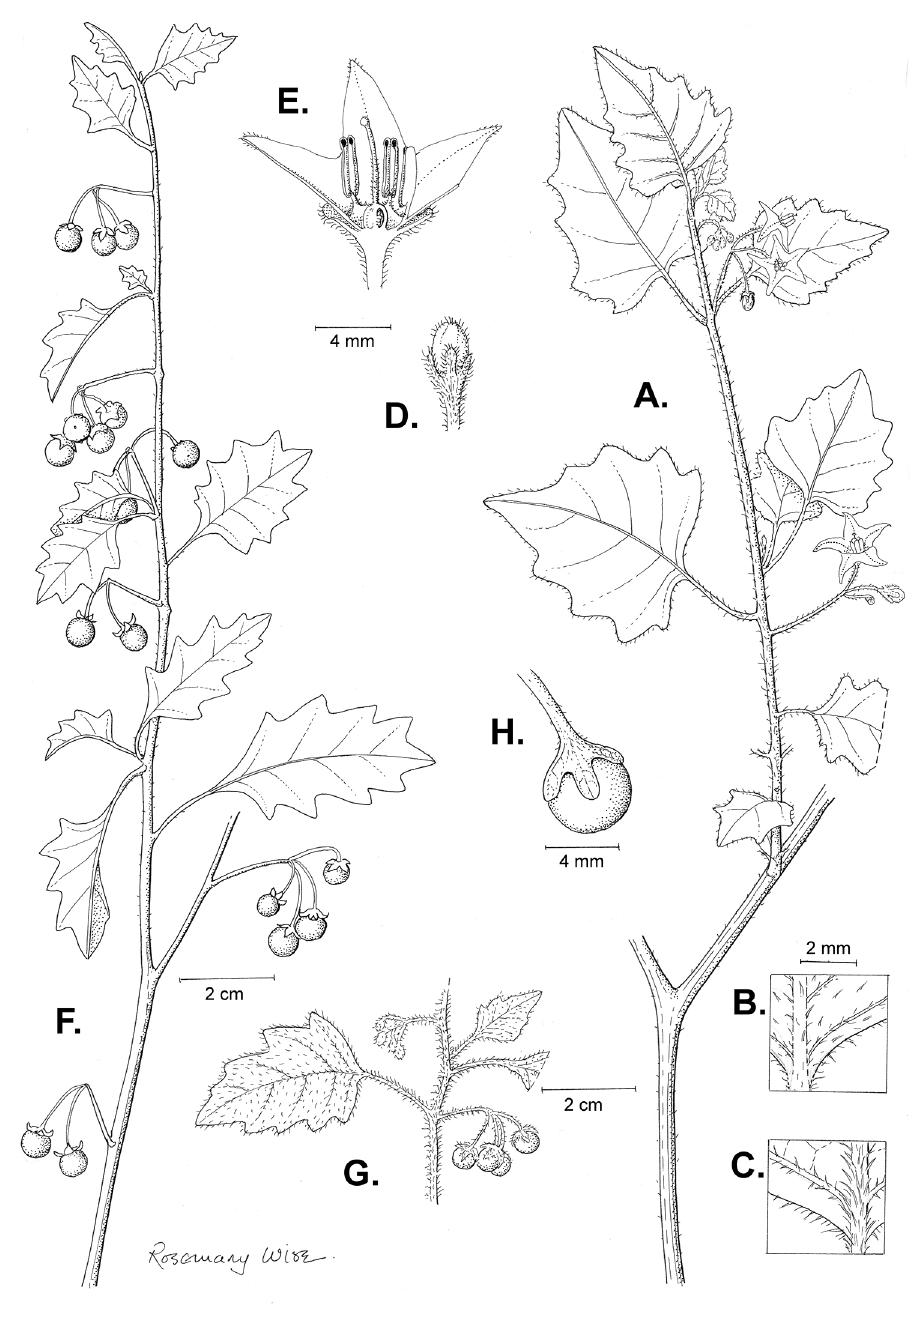
Figure 54. Solanum villosum Mill. A Flowering habit B detail of adaxial leaf surface C detail of abaxial leaf surface D bud E dissected flower F fruiting habit G fruiting habit with dense indumentum H fruit ( A–E Wood 2193 F Popov GP/72/31 G Wood Y/74/265 ). Drawing by R. Wise (previously published in “PhytoKeys